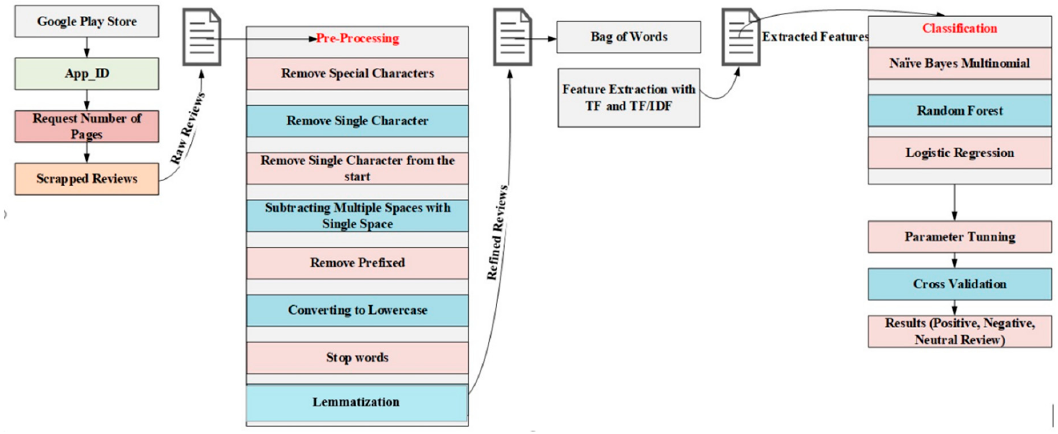
Figure 2. Flow of Google Play Store application reviews classification.